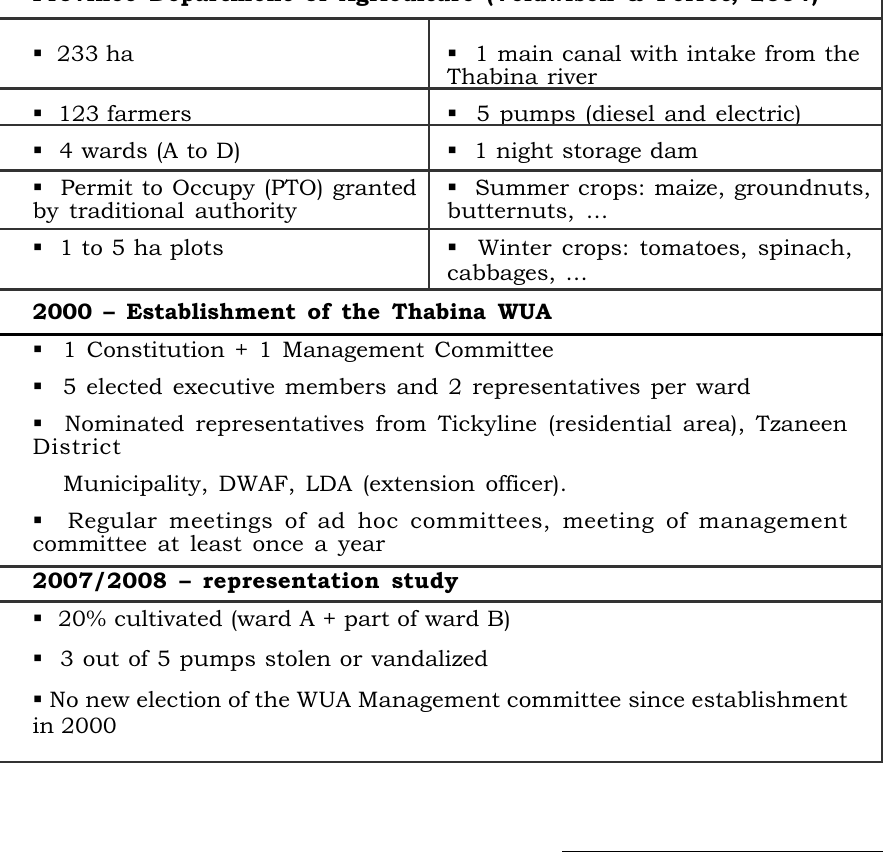
Table 1 Facts about Thabina irrigation